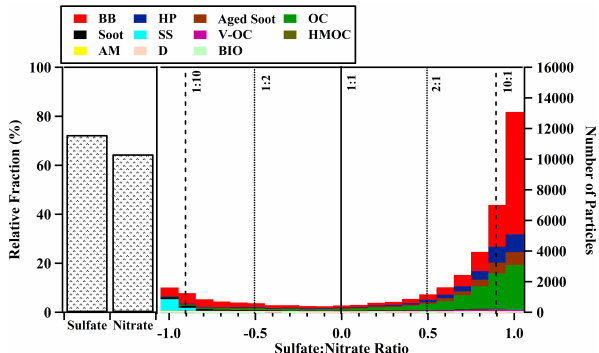
Fig. 7. Fraction of particles containing sulfate and nitrate RPA > 0.5% in northern California (left panel). Sulfate:nitrate ion ratio distributions are shown in (right panel). Values < 0 indicate more nitrate than sulfate and values > 0 indicate more sulfate than nitrate. Ratios representing 1:1, 2:1, and 10:1 are shown by solid, dotted, and dashed lines